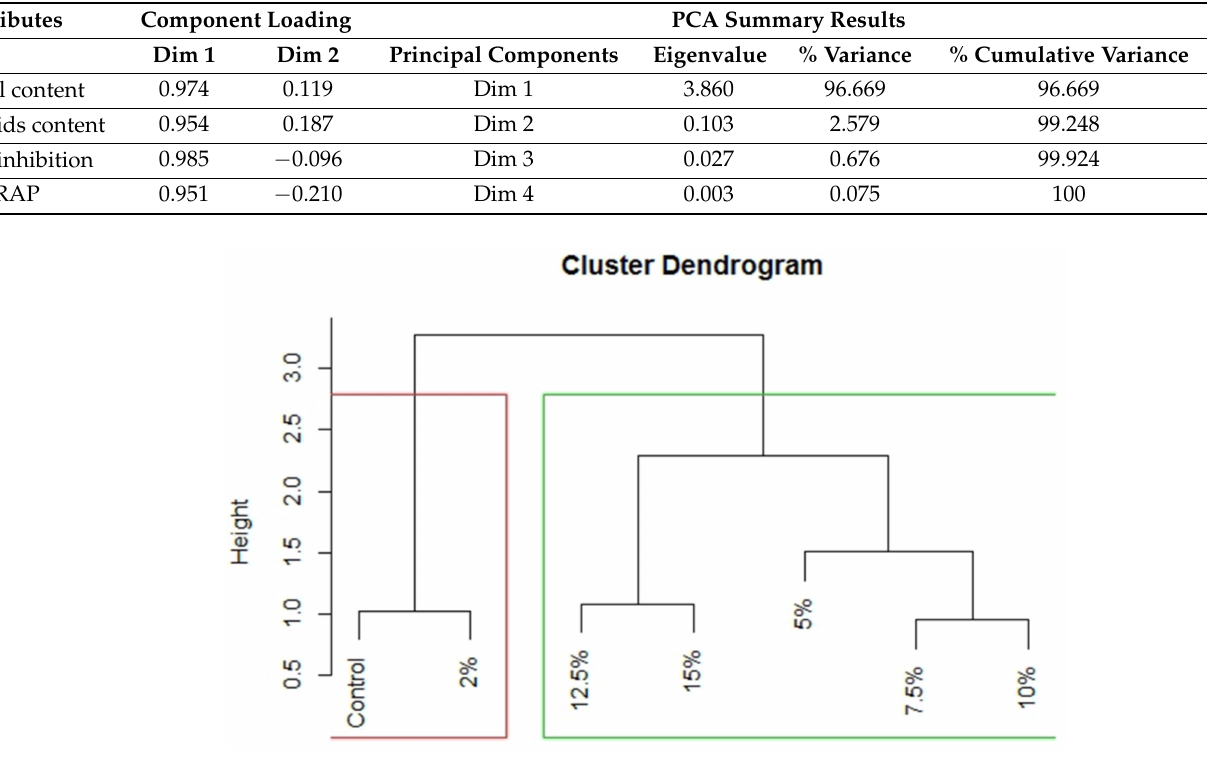
Figure 7. Unweighted pair group method with arithmetic mean (UPGMA) depicting the grouping based on functional and antioxidant